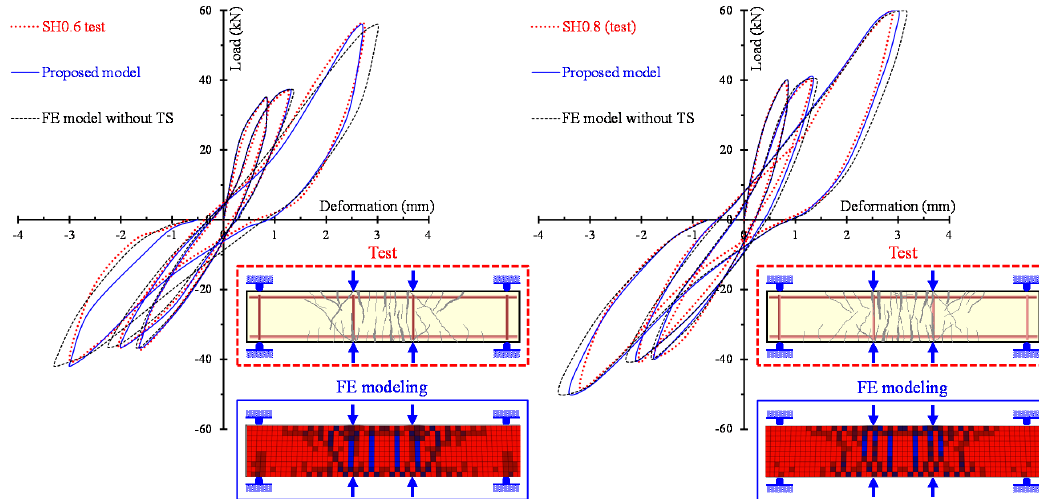
Figure 10. Comparisons between the analytical and experimental hysteretic response and cracking patterns of shear-critical beams without stirrups SH0.3 and SH0.4.